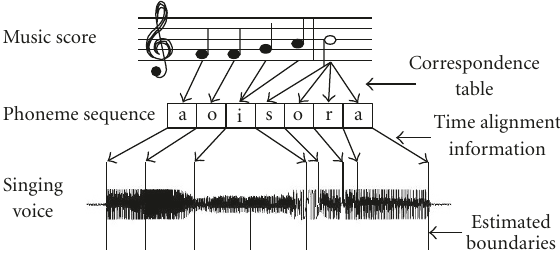
Figure 4: Example of estimation of boundaries between